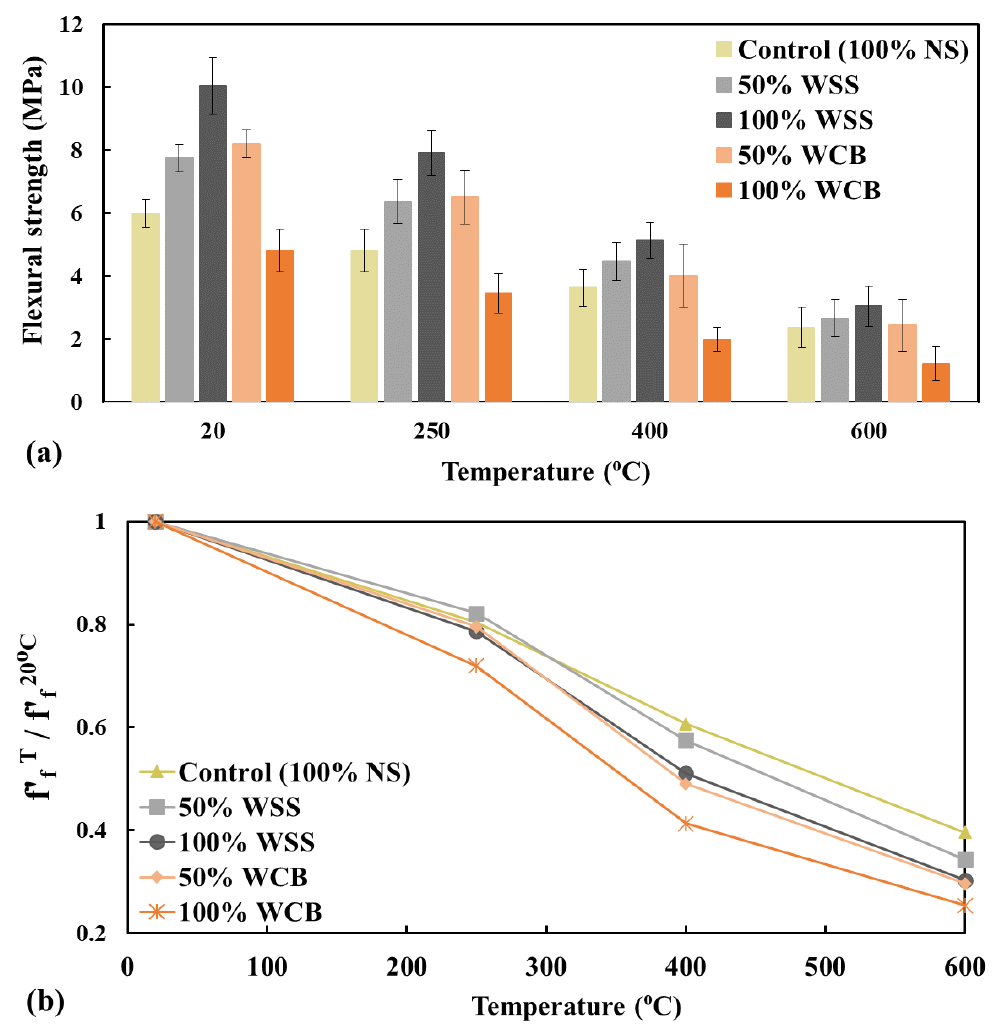
Figure 9. Flexural strength— 𝑓 𝑓′ ( a ) and normalized 𝑓 𝑓′ ( b ) of mortar mixes performed at room temperature after exposure to elevated temperatures.